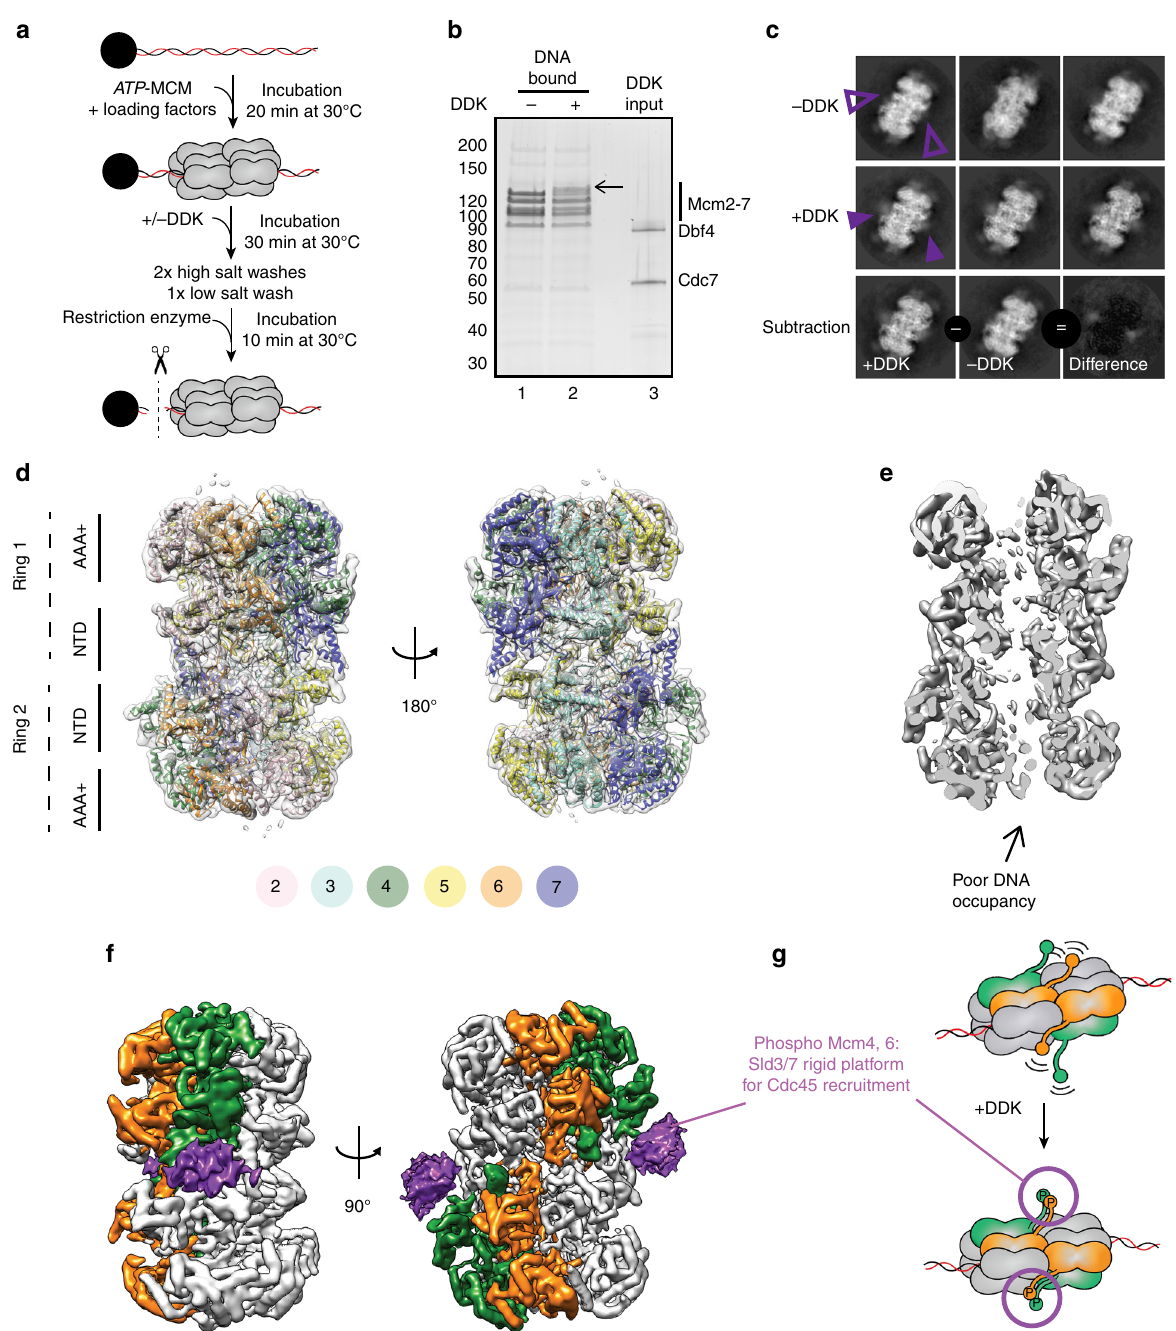
Fig. 1 Structure of the unmodi fi ed and DDK-phosphorylated MCM double hexamer. a Scheme for the loading and phosphorylation of the MCM double hexamer on biotinylated duplex DNA. DDK was removed by high-salt wash. MCM particles retained on digested DNA were used for cryo-EM experiments. b Silver-stained SDS – PAGE gel of (lane 1) unmodi fi ed and (lane 2) phosphorylated MCM compared to the DDK input (lane 3). No trace of DDK is found in the MCM lanes. A black arrow points at the shifted phospho-Mcm6. c 2D class averages of the unmodi fi ed ( fi rst row) and DDK phosphorylated MCM double hexamer (second row). The third row contains a difference image obtained by subtracting unphosphorylated from phosphorylated MCM. Purple arrowheads point to the absence (hollow) or presence ( fi lled) of additional density surrounding the double-hexamer interface in the unmodi fi ed and DDK phosphorylated samples, respectively. d 4.65 Å resolution (unsharpened map) of the DDK phosphorylated MCM double-hexamer with docked in atomic coordinates of yeast MCM (PDB: 3ja8). e A cut-through view of the DDK phosphorylated MCM double hexamer (unsharpened map) reveals a narrowing of the channel at the N-terminal domain interface and a poor occupancy of DNA. f Phosphorylated MCM displayed at σ = 0.37, superposed to a difference map displayed at σ = 0.08 (purple). To obtain the difference map the unmodi fi ed MCM was subtracted from the DDK phosphorylated MCM. g Cartoon depicting the effect of MCM phosphorylation by DDK. Phosphorylation increases rigidity to N-terminal Mcm4-6, which become visible upon